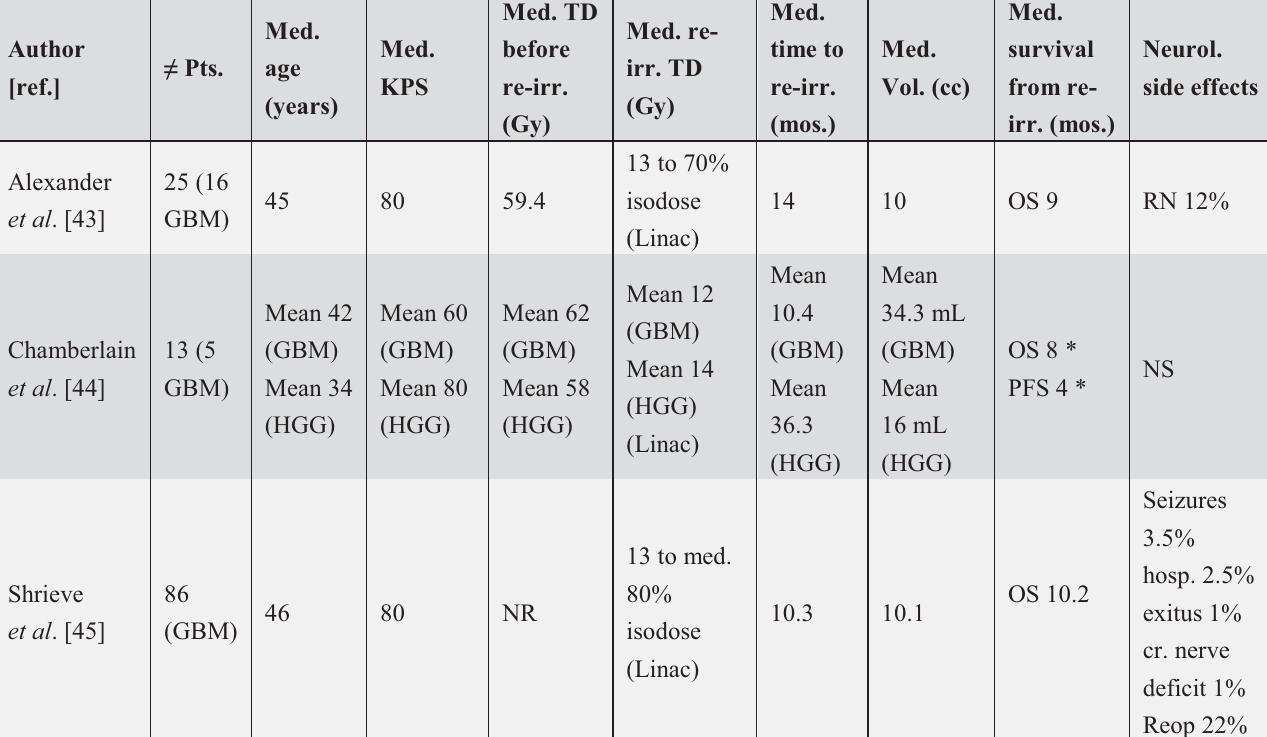
Table 3. Series of high-grade gliomas treated by stereotactic